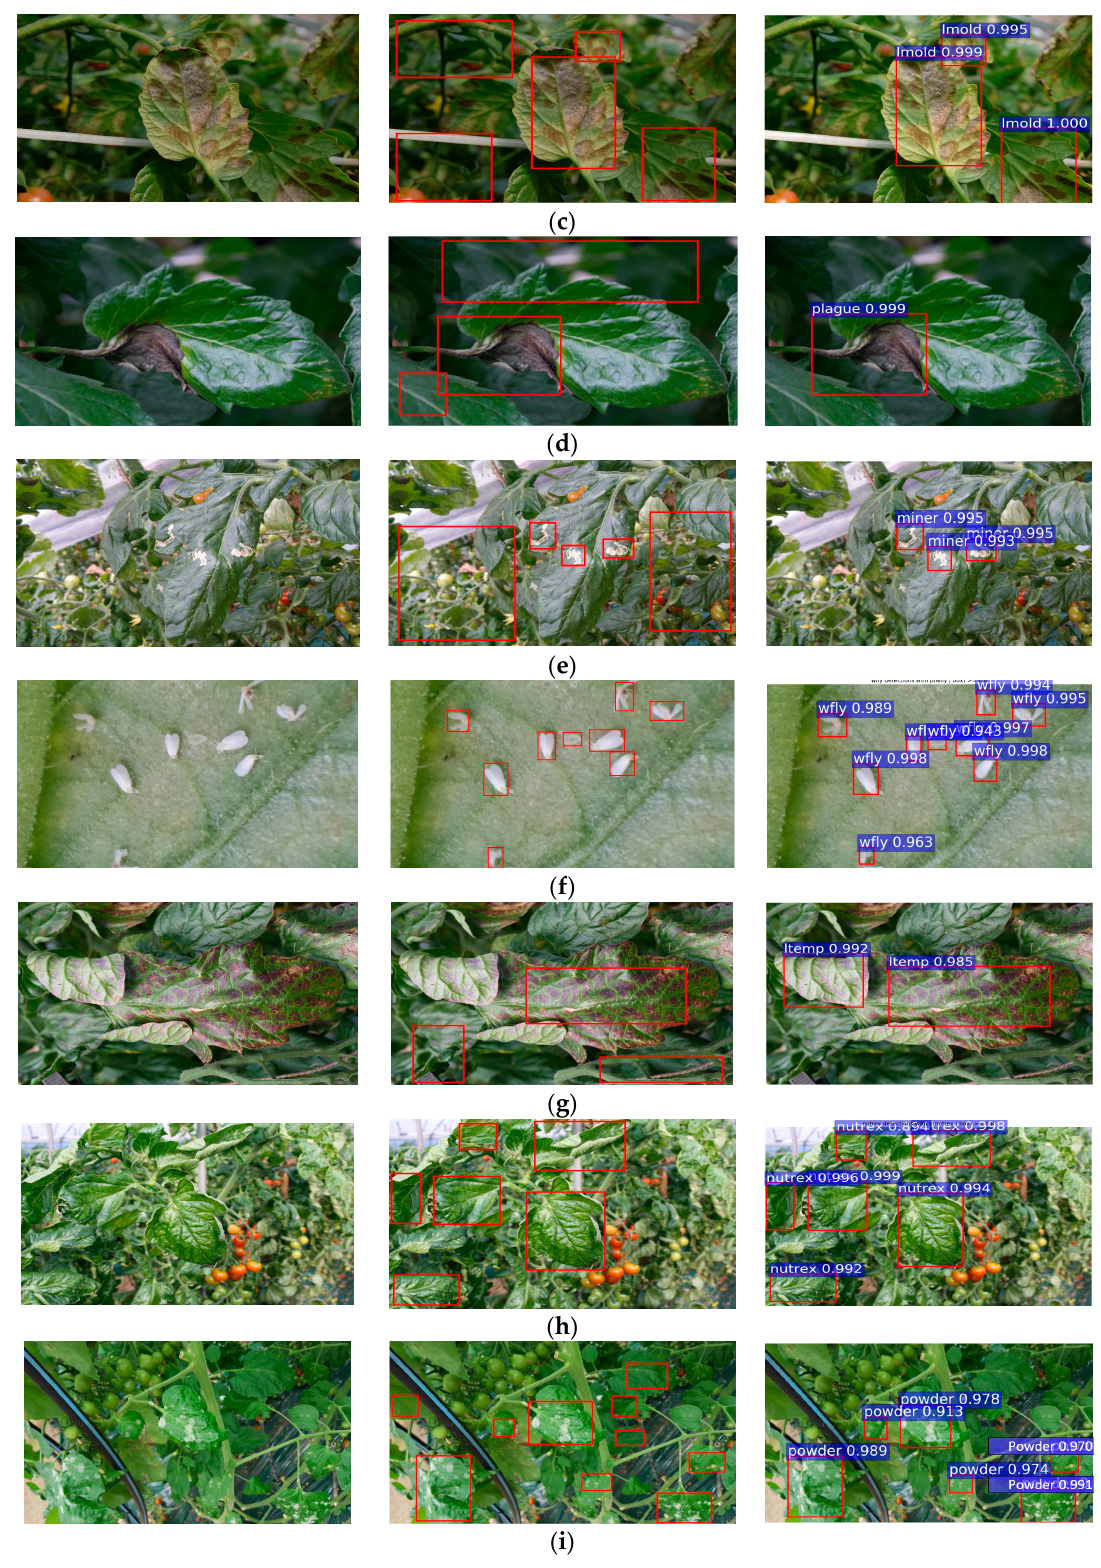
Figure 6. Detection results of diseases and pests that affect tomato plants with Faster R-CNN and a VGG-16 detector. From left to right: the input image, annotated image, and predicted results. ( a ) Gray mold; ( b ) Canker; ( c ) Leaf mold; ( d ) Plague; ( e ) Leaf miner; ( f ) Whitefly; ( g ) Low temperature; ( h ) Nutritional excess or deficiency; ( i ) Powdery mildew.